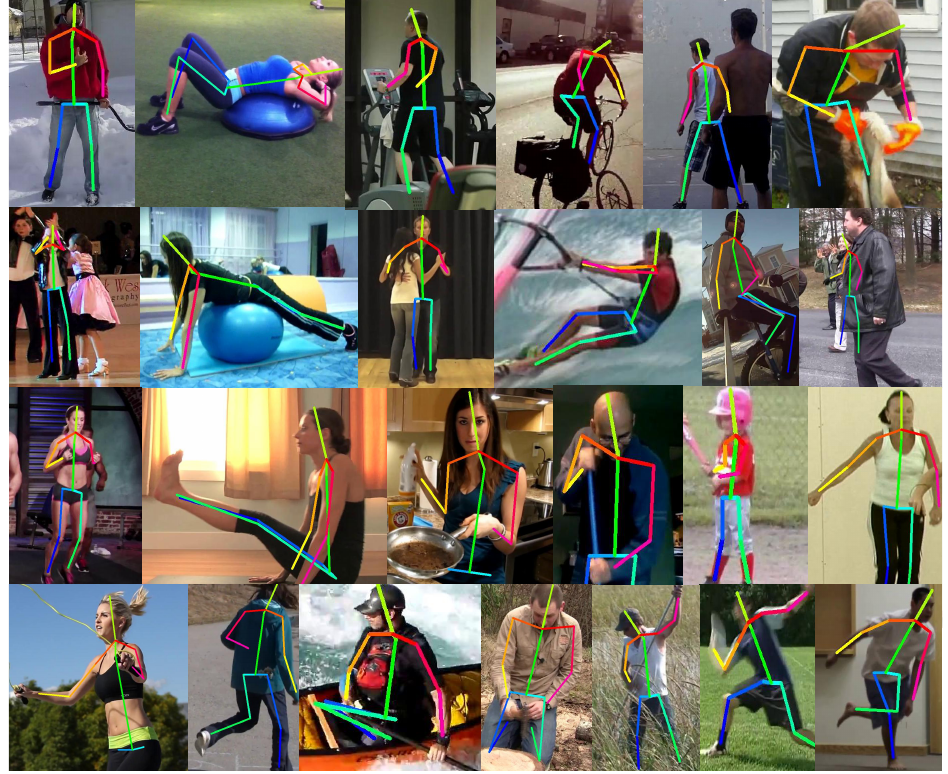
Figure 8. Sample results on the MPII